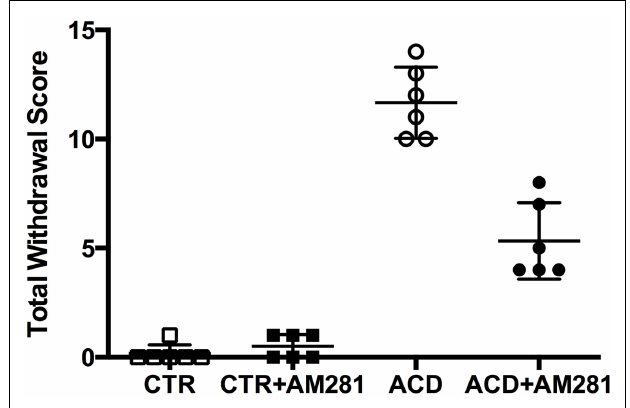
FIGURE 1 |Total withdrawal score . ( (cid:3) ) CTR, ( (cid:4) ) CTR + AM281, ( (cid:13) ) ACD, • and ( ) ACD +